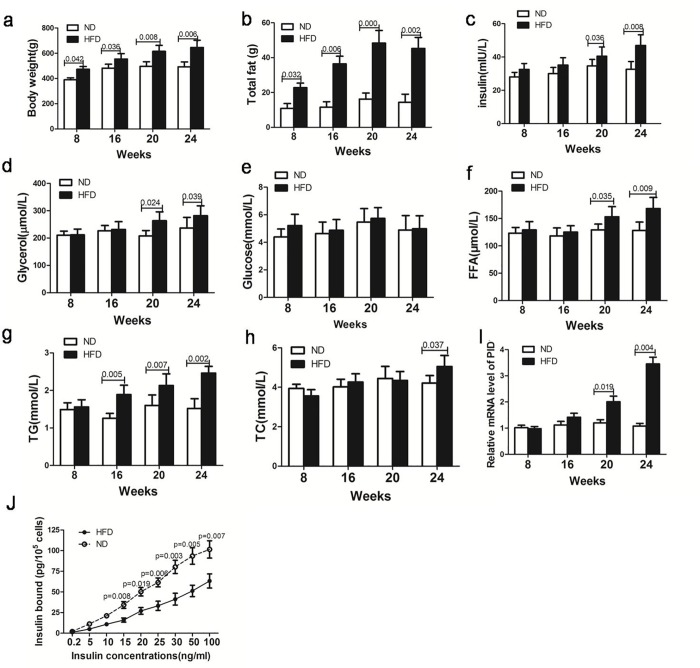
Body weight, total fat, insulin, glycerol, blood glucose, triglyceride, cholesterol and free fatty acid (FFA) levels in ninety-six Sprague-Dawley rats fed either chow (normal diet, ND) or a high-fat diet(HFD) at 8, 16, 20, and 24 weeks (eight rats from the ND group and sixteen rats from the HFD group were randomly selected at each time point).Insulin bound to the receptors of fat cells, and the expression of PID1 in white adipose tissue (WAT) was determined. (a)Body weights of rats in the two groups. (b)Total fat (perirenal and epididymal fat pads) of rats in the two groups. (c)Plasma levels of insulin in the two groups. (d) Plasma levels of glycerol in the two groups. (e) Plasma levels of glucose in the two groups. (f) Plasma levels of FFAs in the two groups. (g) Plasma levels of triglycerides in the two groups. (h) Plasma levels of cholesterol in the two groups.(I)Relative mRNA expression of PID1 in WAT of the HFD and ND groups; the control ratio was normalized to 1. (j)Insulin binding to perirenal adipocytes obtained from HFD and ND rats. Isolated fat cells were incubated with mono-125I-(Tyr A14) insulin with or without various concentrations of unlabeled insulin. Specific insulin binding was determined. Data are presented as the mean±SEM.